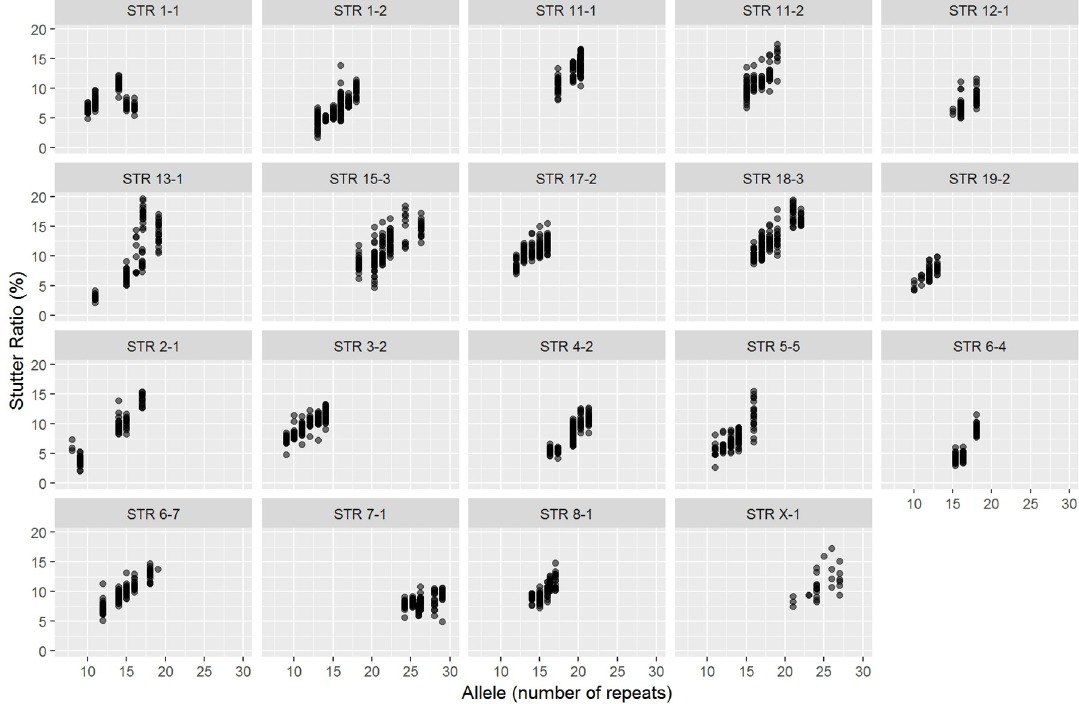
Fig 1. Stutter ratios calculated from diploid mouse DNA samples. Each marker with associated stutter ratios for the represented alleles is plotted here. The y-axis is the observed percent stutter ratio and x-axis shows the allele number (number of repeats).